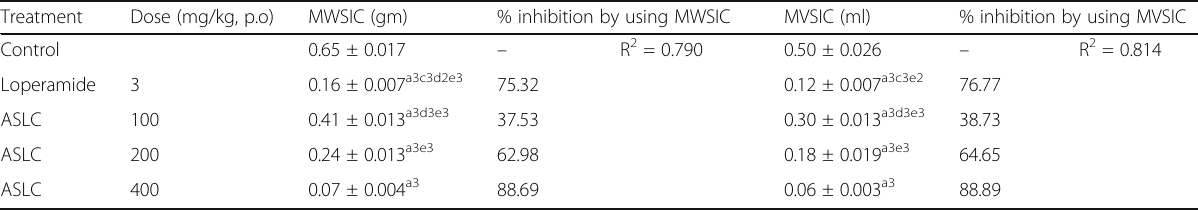
Table 2 Effect of the aqueous stem extract of L. camara on castor oil induced intraluminal fluid accumulation in mice Treatment